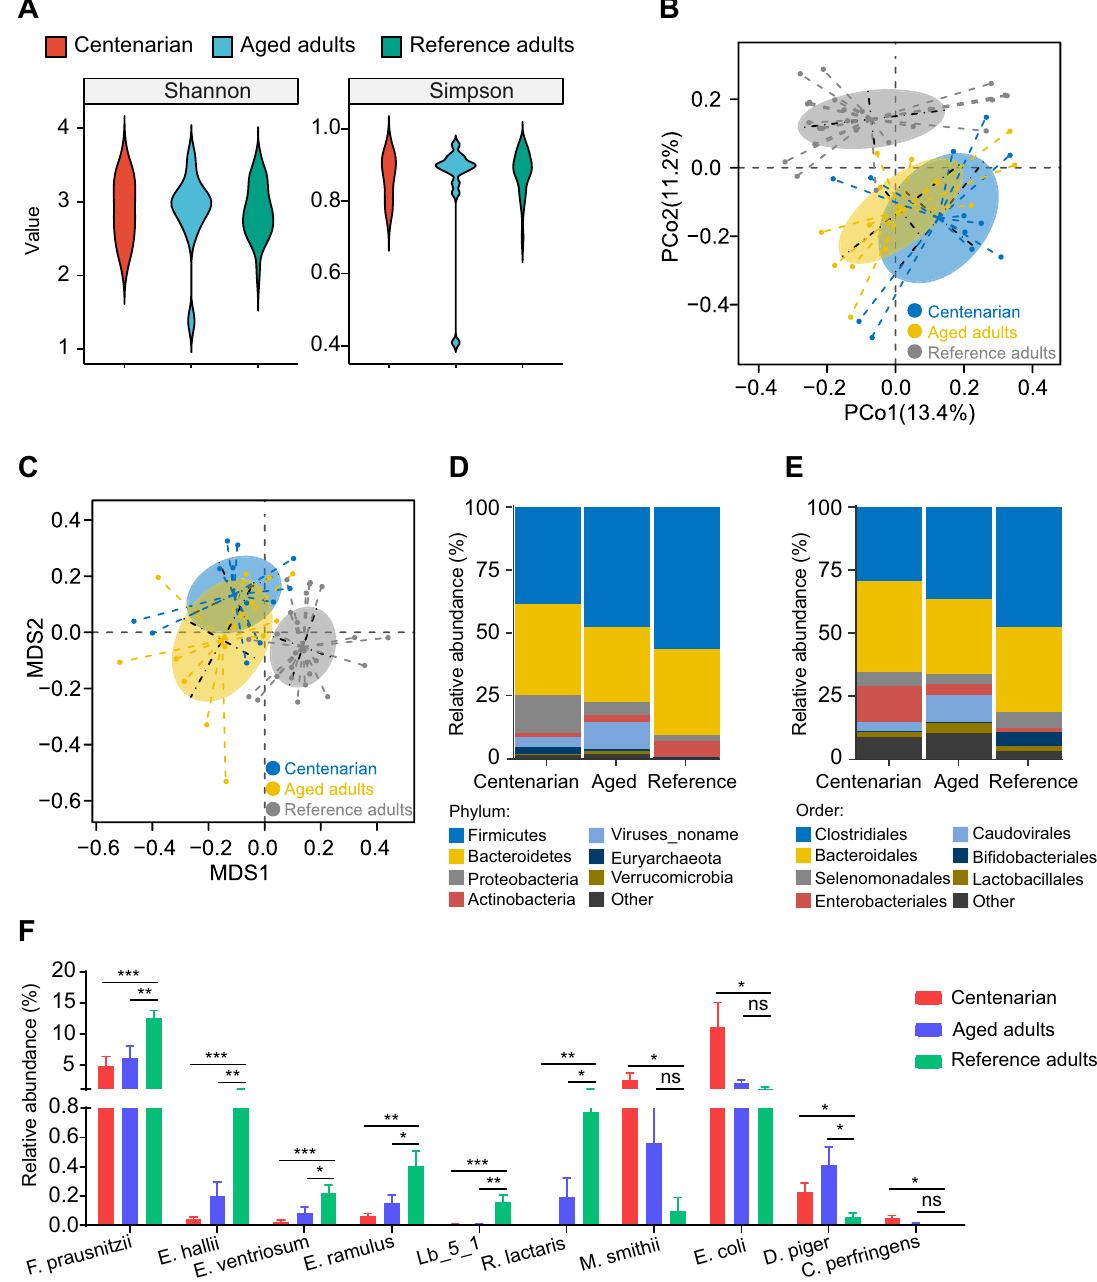
Fig. 4 There is signi fi cant difference in the gut microbiota between the longevous cohort and the ordinary adults in Hainan China. A Alpha diversity. B Principal coordinate analysis (PCoA) analysis. C Non-metric multidimensional scaling (NMDS) analysis. D , E The microbial pro fi le at phylum ( D ) and order ( E ) levels. F The main species that changes constantly with aging. Lb_5_1 refers to Lachnospiraceae_bacter- ium_5_1. * P < 0.05, ** P < 0.01, *** P < Firmicutes (134 species), Proteobacteria (38 species), Bacteroidetes Lactobacillus johnsonii (3.08 vs. 0.08), L. kalixensis (4.58 vs. 0.15), (27 species), Actinobacteria (19 species), Fusobacteria (2 species), L. oris (2.75 vs. 0.23), L. agilis (5.67 vs. 0.62), L. gasseri (4.42 vs. 0.54) Ascomycota (1 species), and Agaricomycotina (1 species). A total and Enterococcus dispar (15.17 vs. 1.92) were much higher in of 69 genera were identi fi ed in which Lactobacillus , Bacillus , centenarians, while Brevibacillus borstelensis (0.00 vs. 4.08), Enterococcus , Streptococcus and Clostridium were mostly presented Mitsuokella multacida (0.33 vs. 4.62), Enterococcus asini (0.25 vs. (Fig. 7, Additional fi le 2: Table S5). 3.00), Bi fi dobacterium pseudolongum (0.25 vs. 2.54) and L. reuteri The average isolated strain number (322.92 vs. 317.77, p = (1.33 vs. 8.23) were higher in non-centenarians (Additional fi le 2: 0.959) and species number (48.00 vs. 53.62, p = 0.592) per subject Table S7). In general, centenarians presented higher amount of were similar between the centenarians and non-centenarians culturable Lactobacillus and Enterococcus , which was in accor- (Additional fi le 2: Table S6). However, the average number of dance with the metagenomic analysis (Fig. 4E).